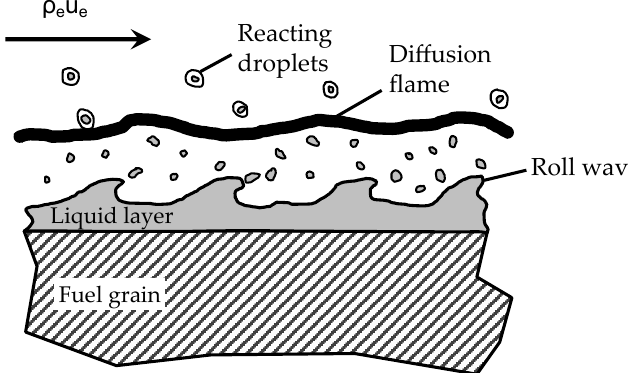
Figure 3. Schematic of the entrainment mechanism, as presented in